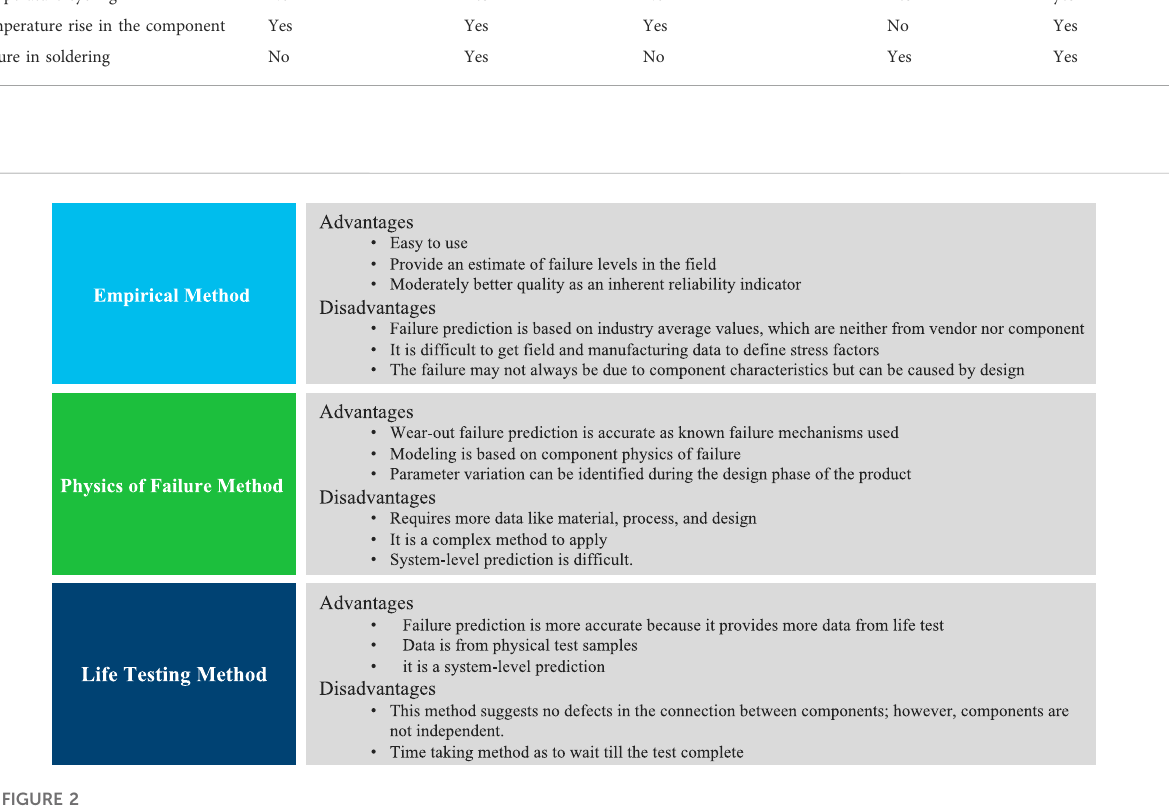
FIGURE 2 Advantages and disadvantages of failure prediction